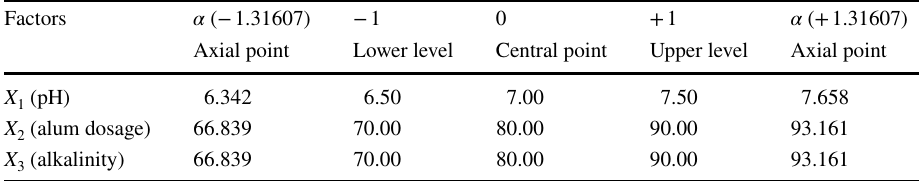
Table 3 Experimental range and levels for rotatable central composite design